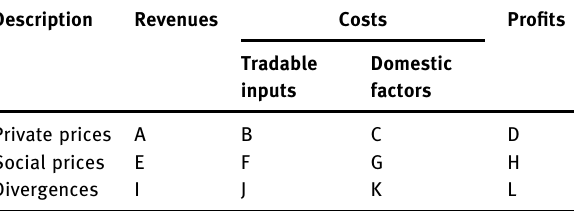
Table 1: Policy analysis matrix ( PAM ) [ 20